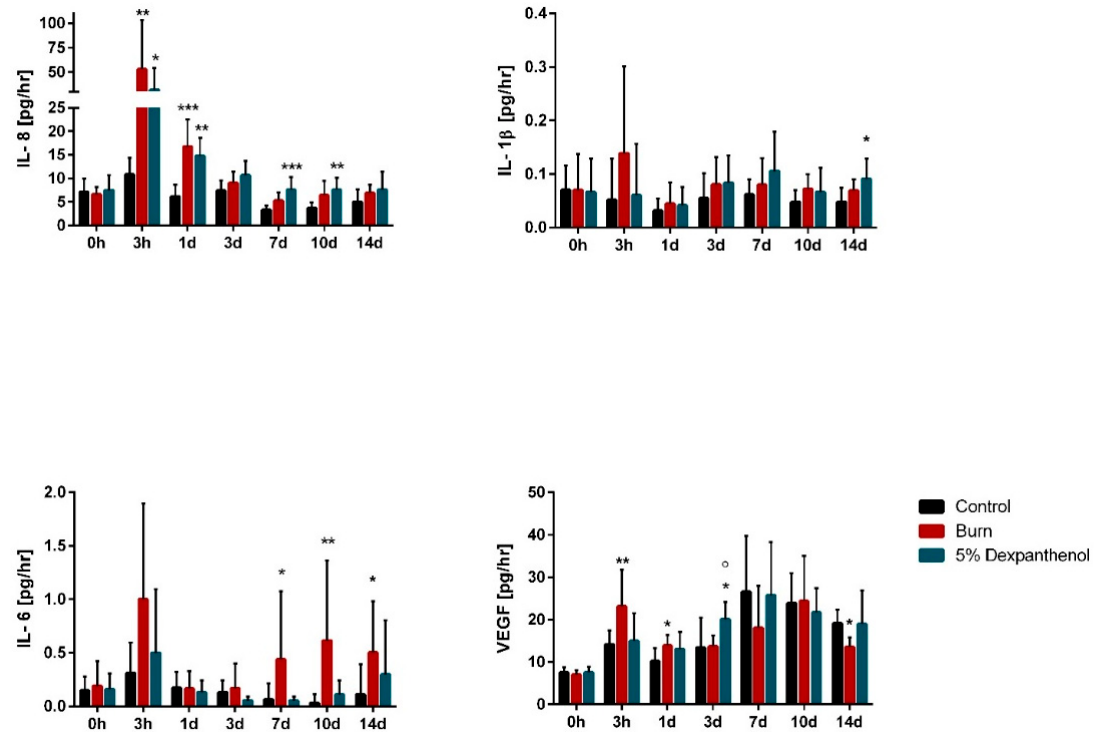
Figure 7. Infliction of burn wounds causes an inflammatory response in reconstructed human epidermis. Concentrations of inflammatory cytokines IL-8, IL-6, IL-1 β , and VEGF in cell culture supernatants of burned and unwounded models at distinct time points over 14-day period determined by CBA. The detected IL-8 and VEGF levels peaked 3 h after burning. IL-6 and IL-1 β were very low at any given time point (3 biological replicates in independent test runs with 3 technical replicates each; mean values ± SD; Kruskal-Wallis test with Dunn’s multiple comparisons test, * p < 0.5, ** p < 0.01, *** p < 0.001, compared to the control; ◦ p < 0.05, compared to burned